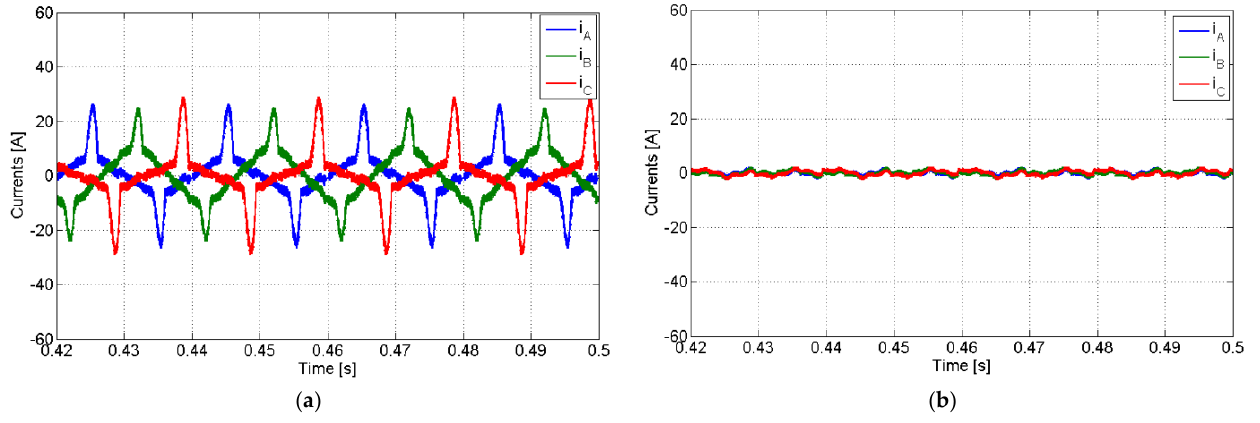
Figure 21. Simulation results with the PV generator in full compensation mode with a non-linear load and for compensation of the reactive power and harmonics: ( a ) AC currents of the PV generator; ( b ) grid currents.